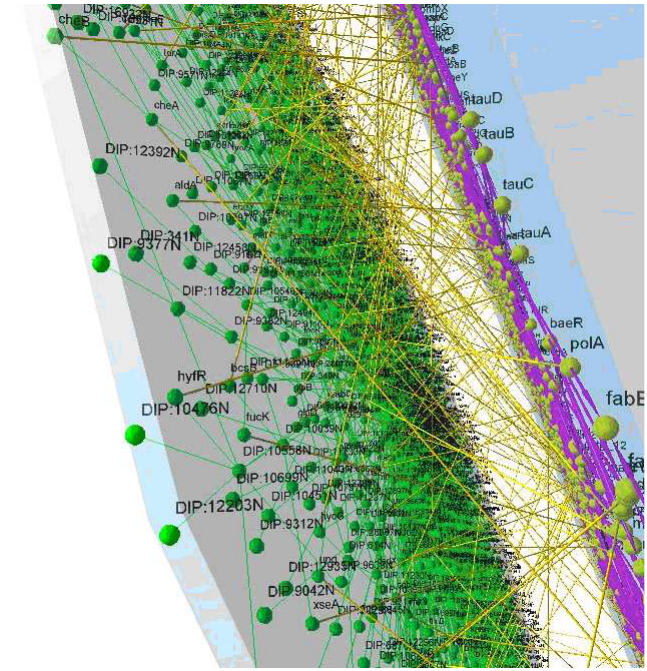
Figure 5: Enlargement of the visualisation in Figure 4 which shows numerous inter-cluster edges (yellow colour) between G 1 and G 2 representing the gene regulatory proteins that were also present in the protein interaction network.